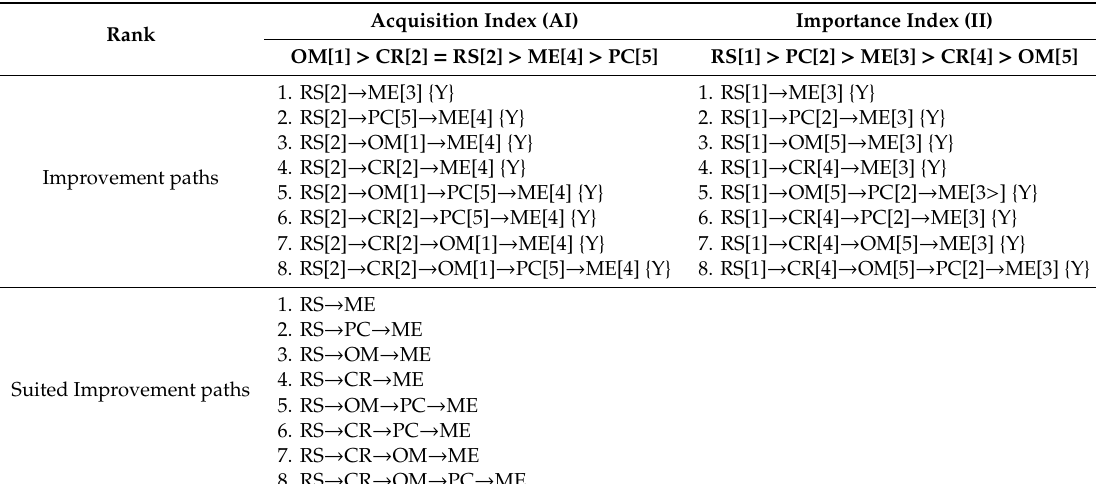
Table 12. The suited improvement paths of digital